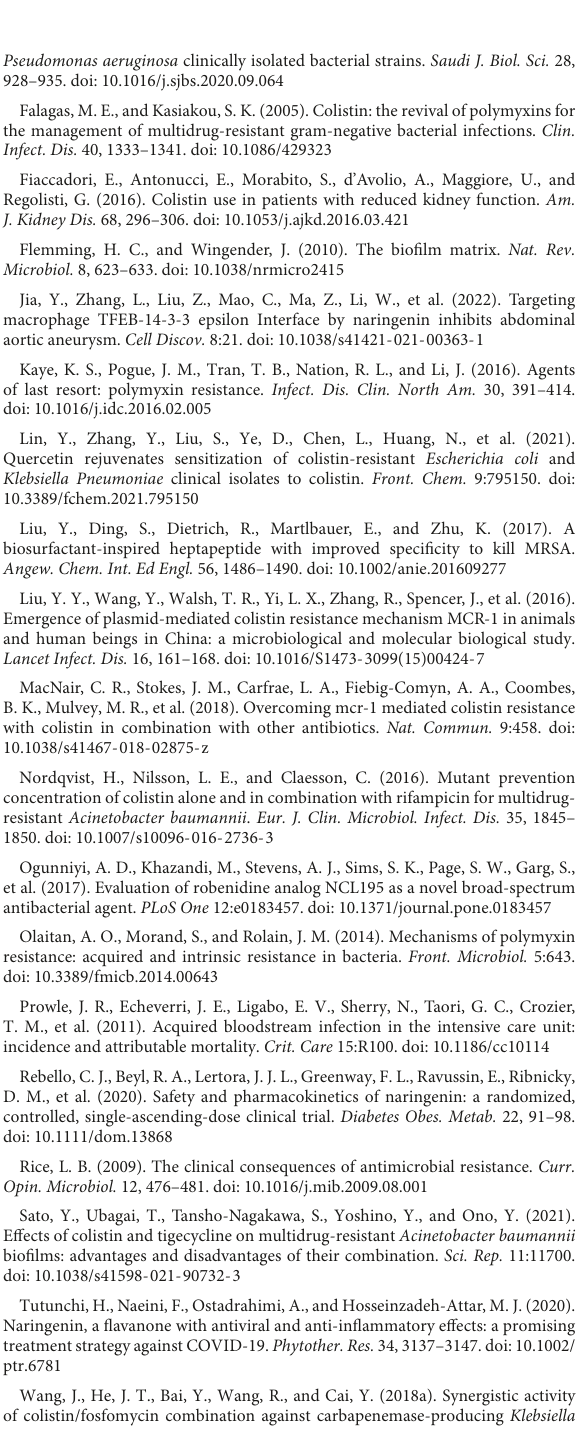
colistin-resistant Acinetobacter baumannii . The absorbance of the bacterial cultures at 600 nm is shown at 16–20 h incubation. The dark blue area represents higher cell density. Data represent the mean OD 600 of three biological replicates. Naringenin (NG) and colistin